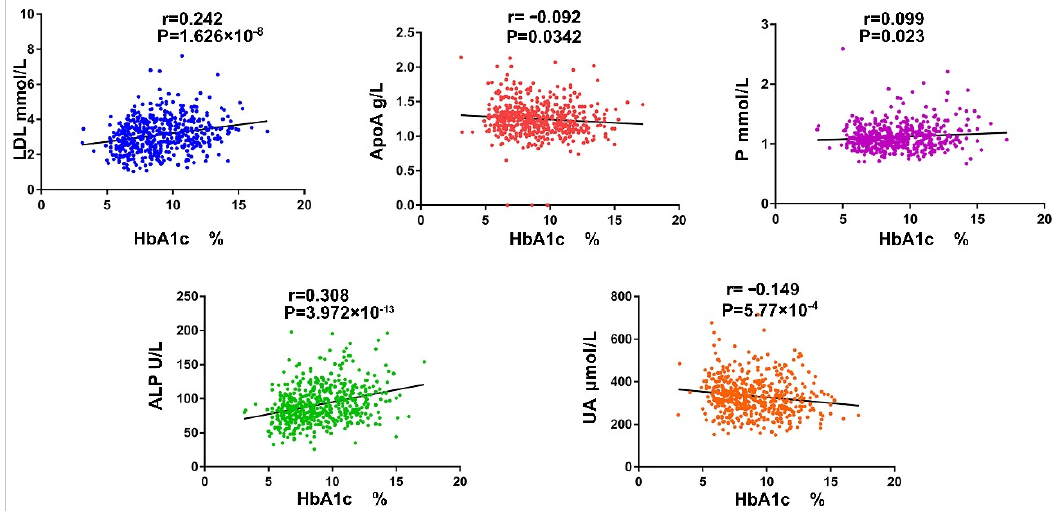
Figure 1. The case data from of T2DM patients. Pearson correlation analysis between HbA1c and serum low density lipoprotein (LDL), ApoA, P ion, ALP and uric acid (UA). Table 1. Multiple linear regression analysis for determining the risk factors of HbA1c.